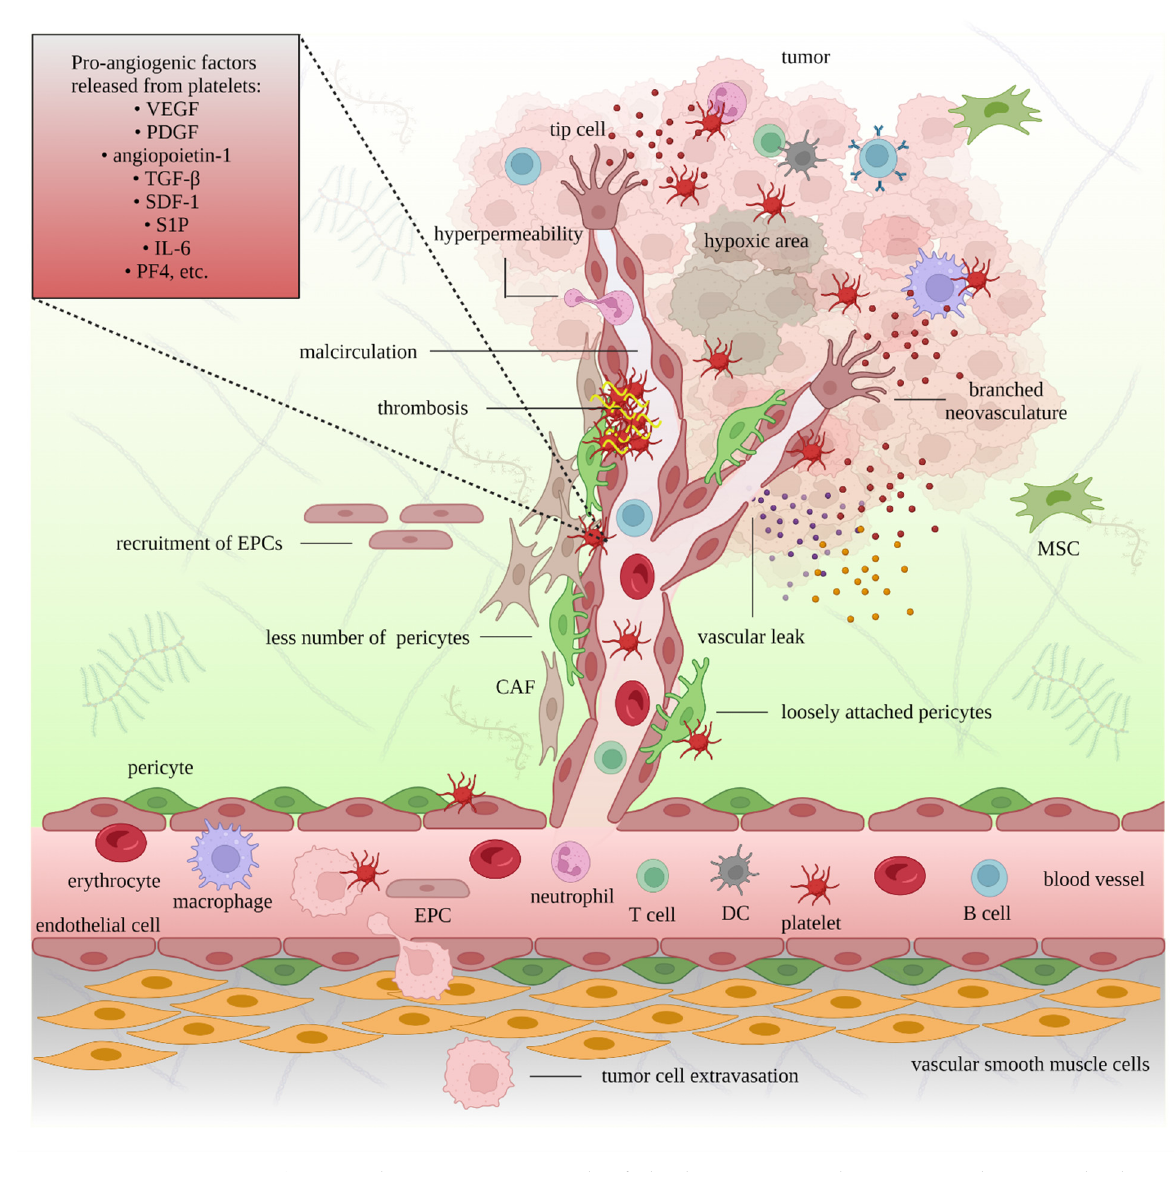
Figure 2. The pro-angiogenic role of platelets in cancer. The interaction between platelets, endothelial cells, and pericytes supports the extravasation of immune cells, mesenchymal stem cells (MSCs), endothelial precursor cells (EPCs), and tumor cells. Platelets also release proangiogenic factors that promote new blood vessel formation and facilitate tumor growth. The newly formed cancer-associated blood vessels are branched, leaky, and less supported by pericytes. Insufficient oxygen and nutrient supplies lead to hypoxic and necrotic areas in the tumor. Platelet-targeting strategies can restrict neoangiogenesis.